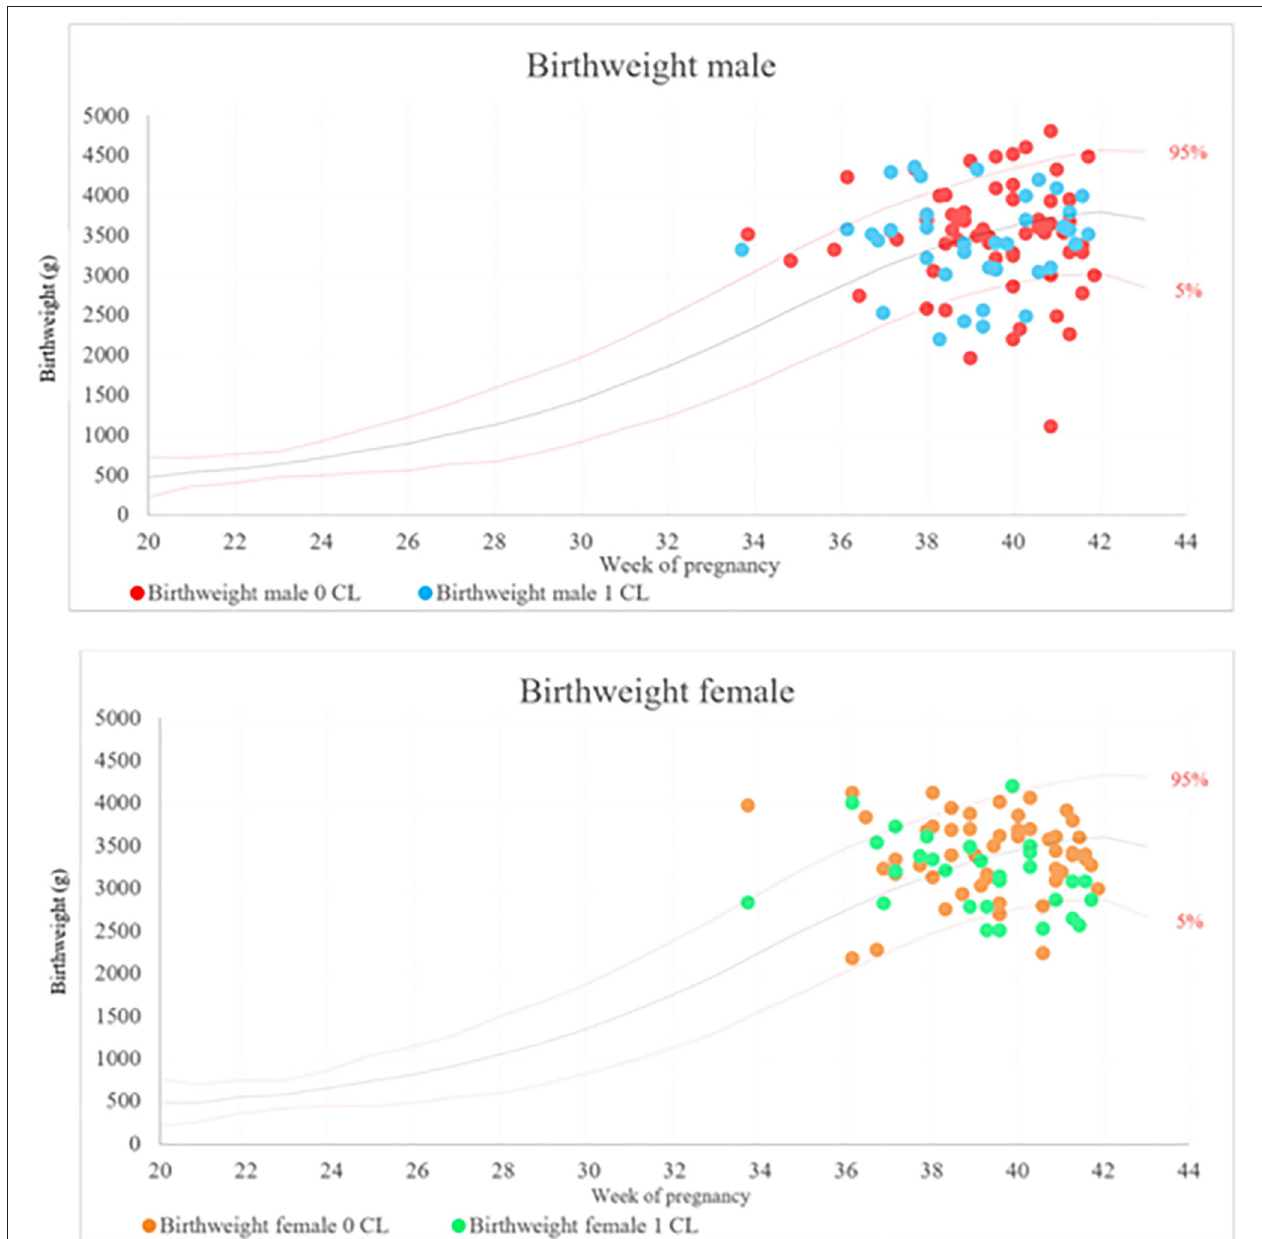
FIGURE 1 | Birthweight of male and female newborn plotted against the gestational week for frozen-thawed embryo transfer in the absence (0 CL) or presence ( ≥ 1 CL) of a corpus luteum in German normality curves.